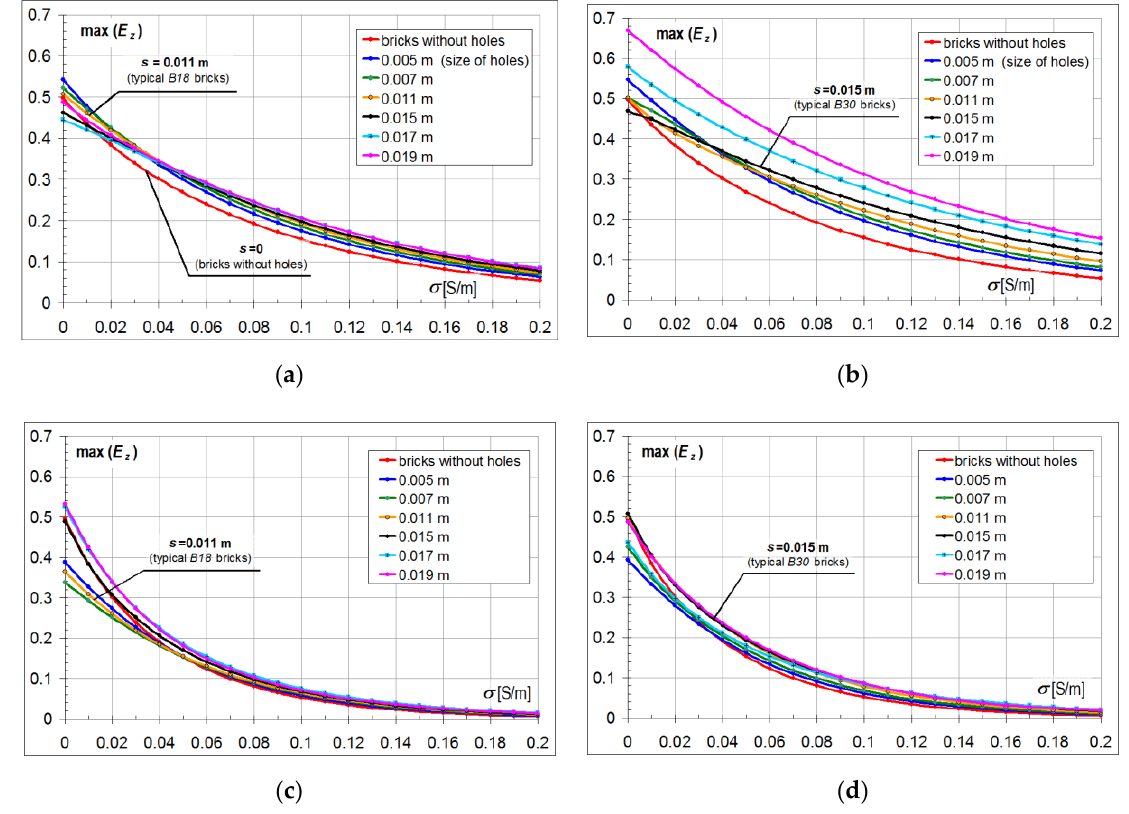
Figure 6. The relative maximum values of the E z component behind the wall made of: ( a ) B18 bricks (one layer), ( b ) B30 bricks (one layer), ( c ) B18 bricks (two layer), ( d ) B30 bricks (two layer).